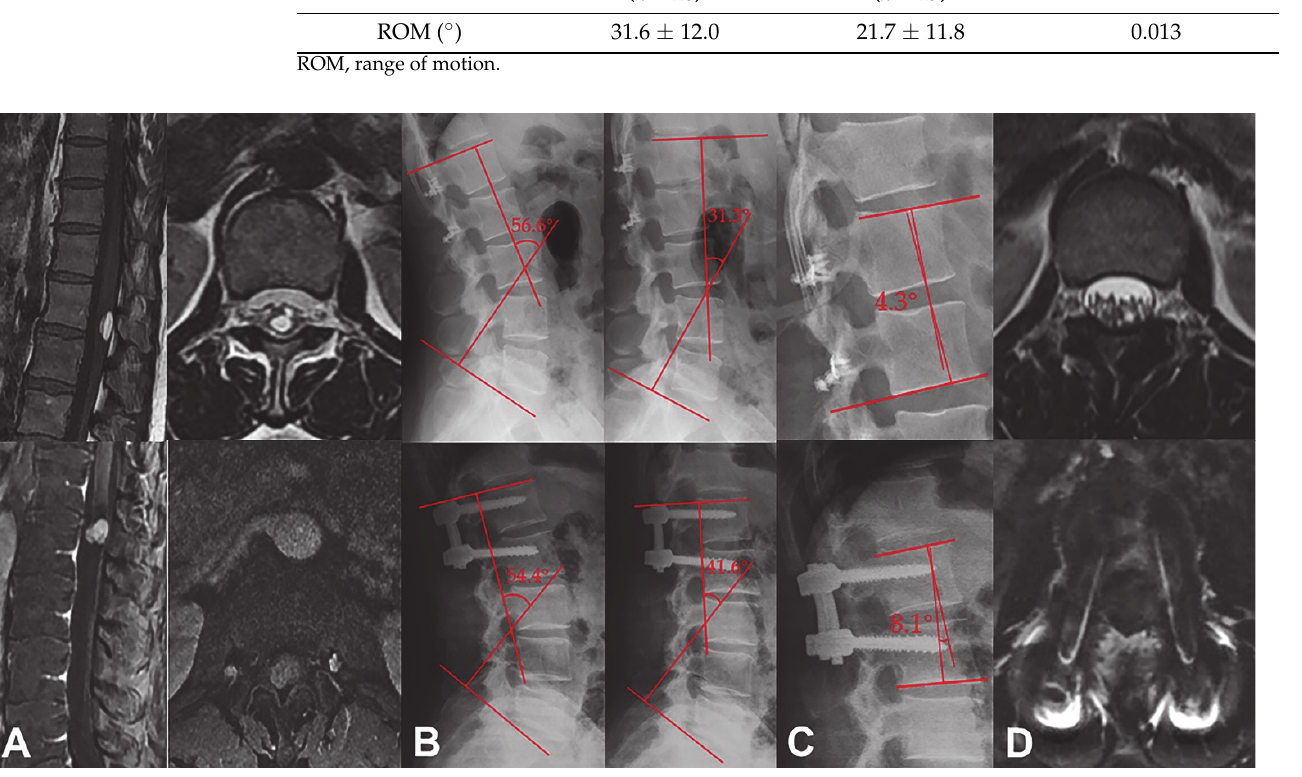
Figure 3. Radiographic findings were compared between a 38-year-old female patient in laminoplasty group and a 50-year-old female patient in laminectomy group. ( A ) Preoperative MRI identified the tumor at L1 level in the patient in laminoplasty group and the tumor at L1–L2 level in the patient in laminectomy group. ( B ) Postoperative L-spine lordotic kyphotic X-ray film showed that the lumbar ROM of the patient in laminoplasty group was 25.3 ◦ vs. 12.8 ◦ in laminectomy group. ( C )